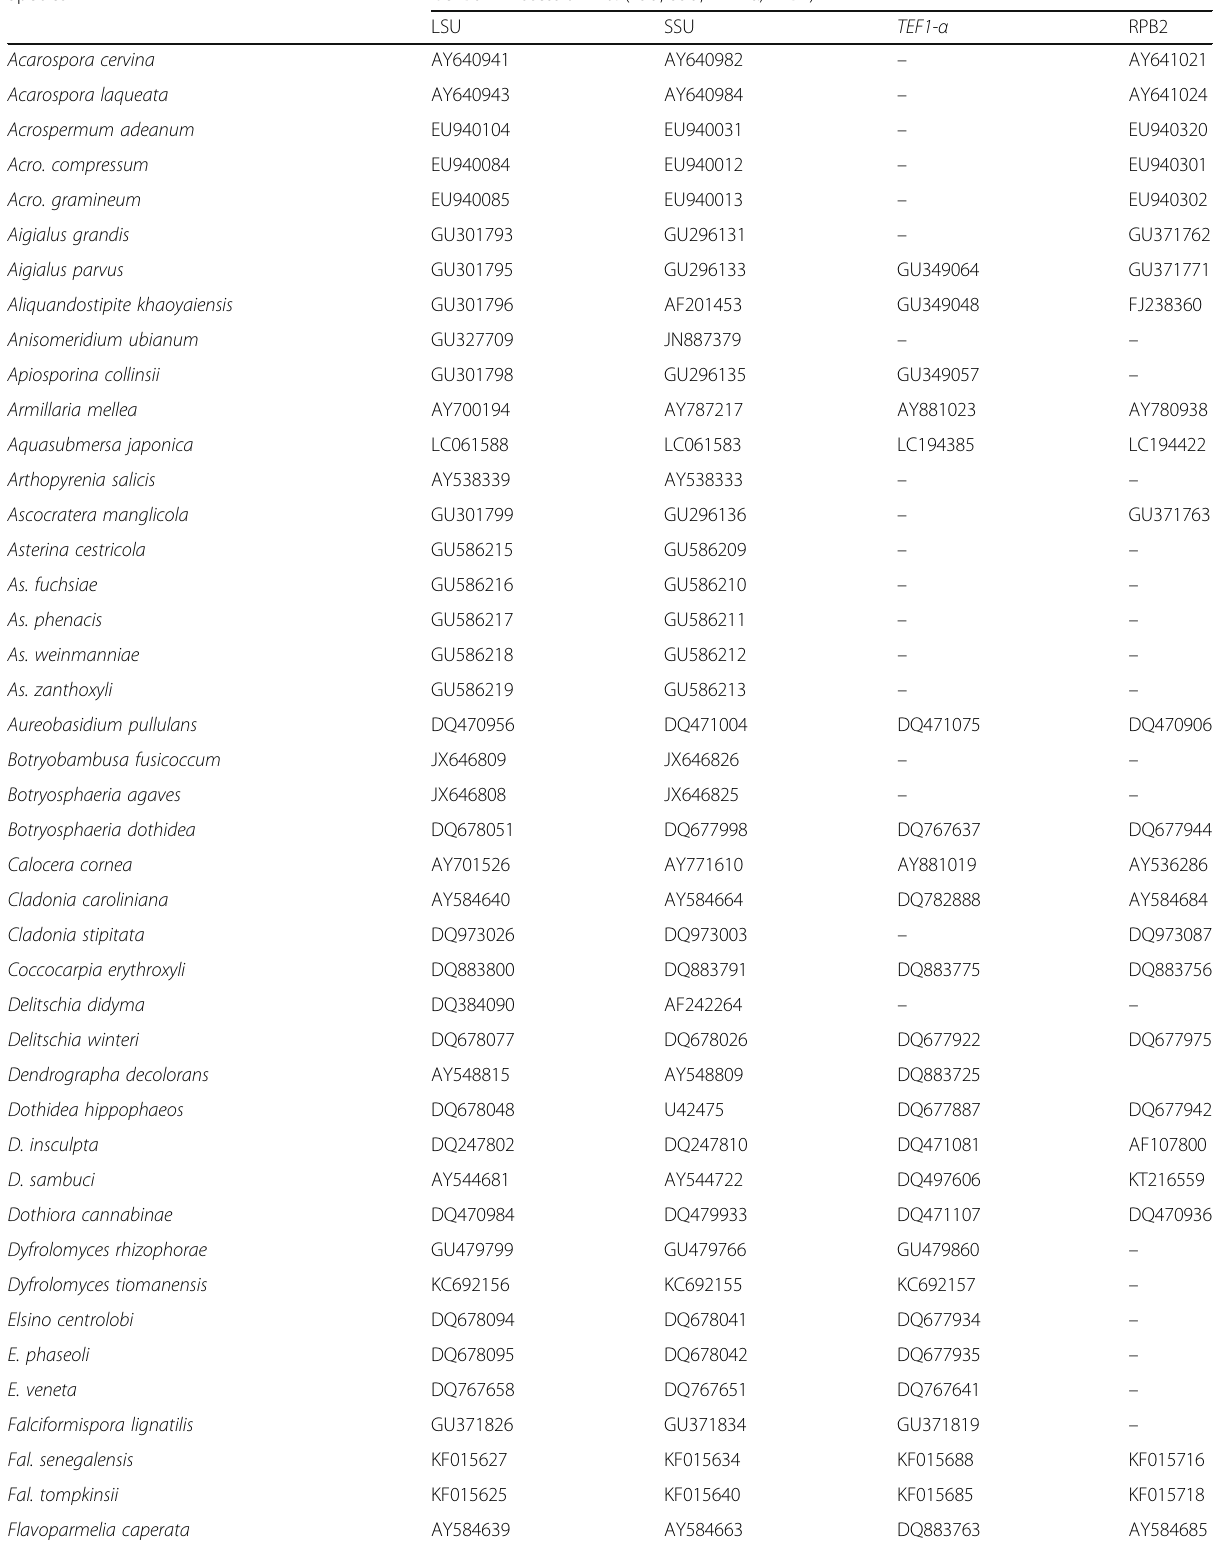
Table 3 Other sequences retrieved from GenBank for phylogenetic analysis